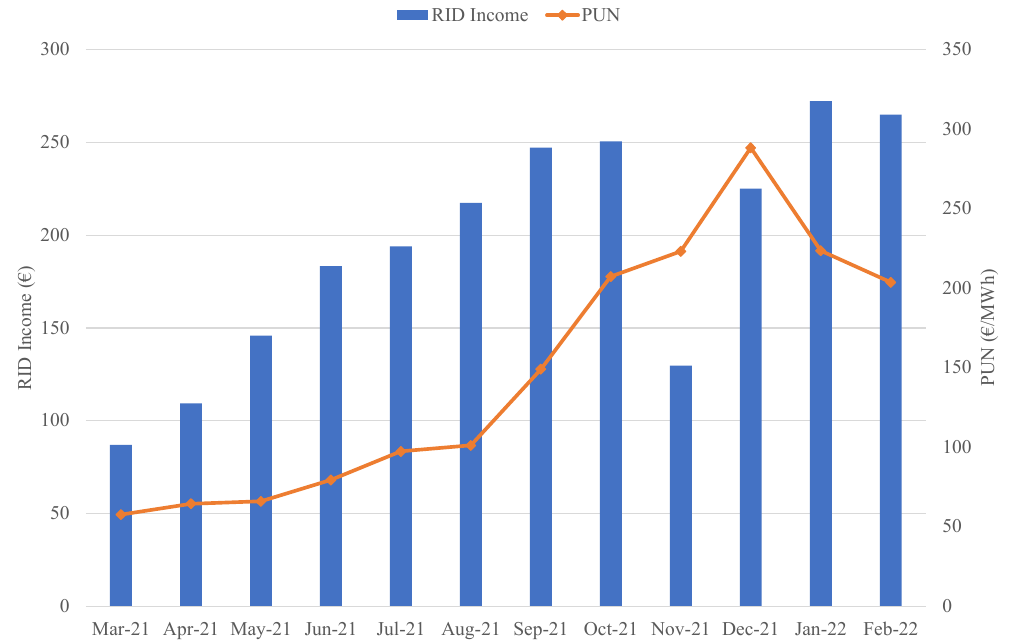
Figure 9. RID and PUN—monthly statistics.